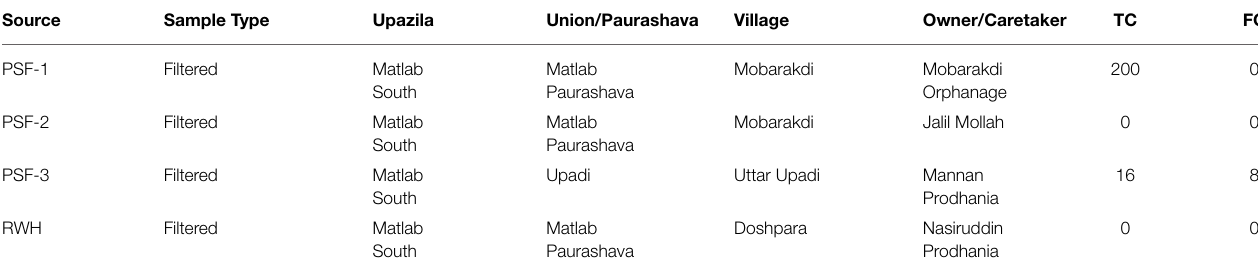
TABLE 9 | TC and FC of water collected from functional PSF and RWH.